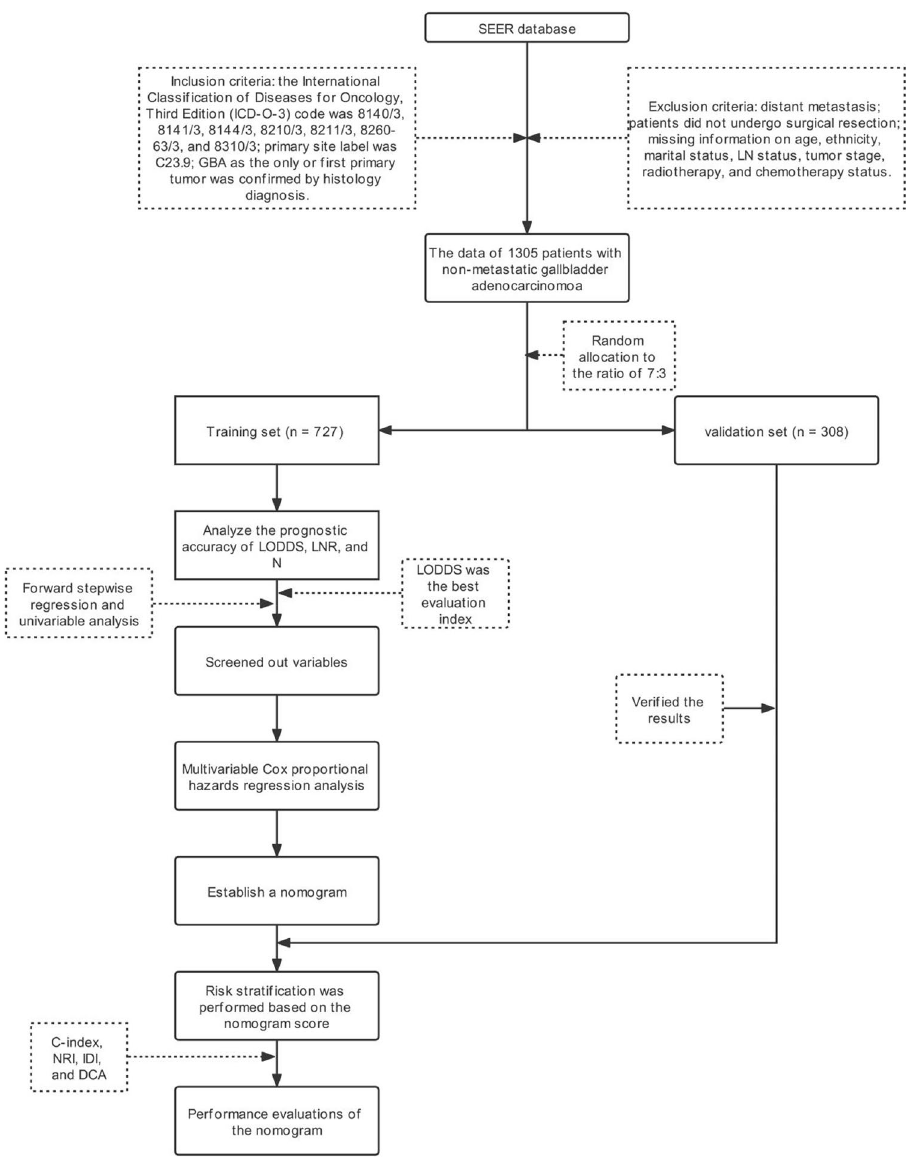
Figure 1. Enrollment flow chart of eligible patients in the present